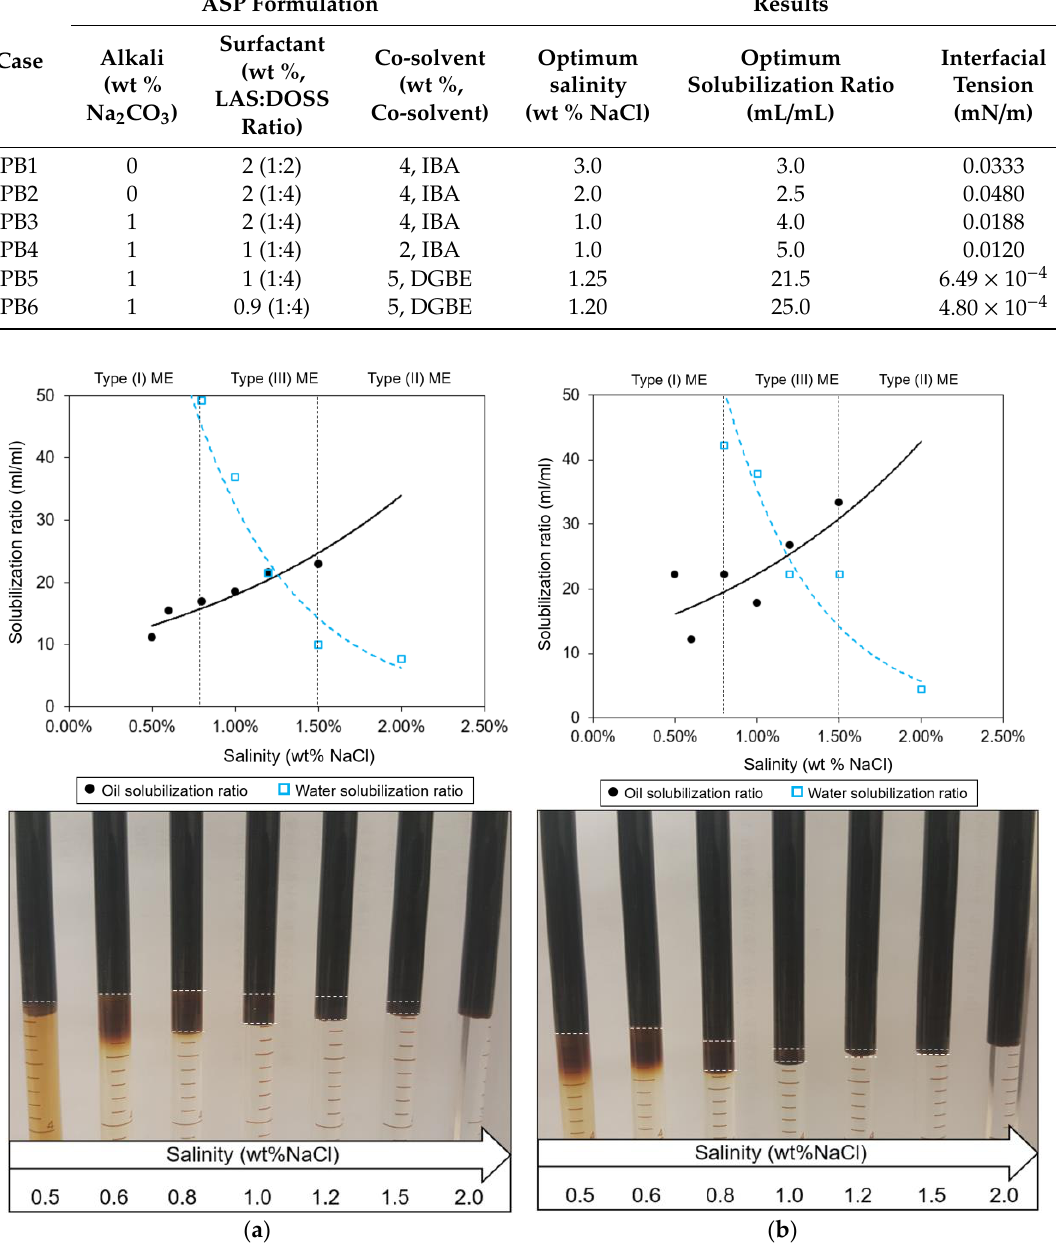
Figure 2. Plot of solubilization ratio with increasing salinities to determine the optimum salinity and phase type with two formulas: ( a ) 1 wt % Na 2 CO 3 as the alkali, 5 wt % DGBE as the co-solvent, and 1 wt % 1:4 ( wt / wt ) LAS:DOSS mixture as the surfactant (PB5); and ( b ) 1 wt % Na 2 CO 3 as the alkali, 5 wt % DGBE as the co-solvent, and 0.9 wt % 1:4 ( wt / wt ) LAS:DOSS mixture as the surfactant (PB6). The horizontal dashed lines in the lower-side pictures represent the boundaries of a microemulsion. The weight percentage range of NaCl was assumed to be from 0.8 to 1.5 wt % in the